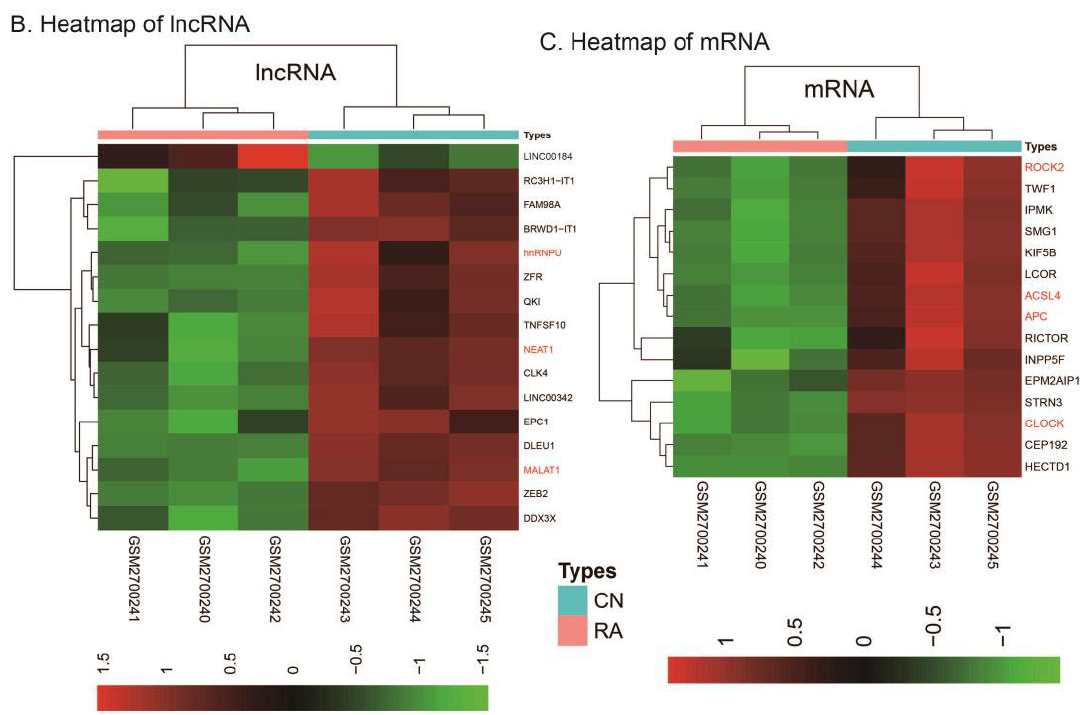
Figure 3. ( A ) The ceRNA network. ( B ) Heatmap of lncRNAs in the ceRNA network. ( C ) Heatmap of mRNAs in the ceRNA network.